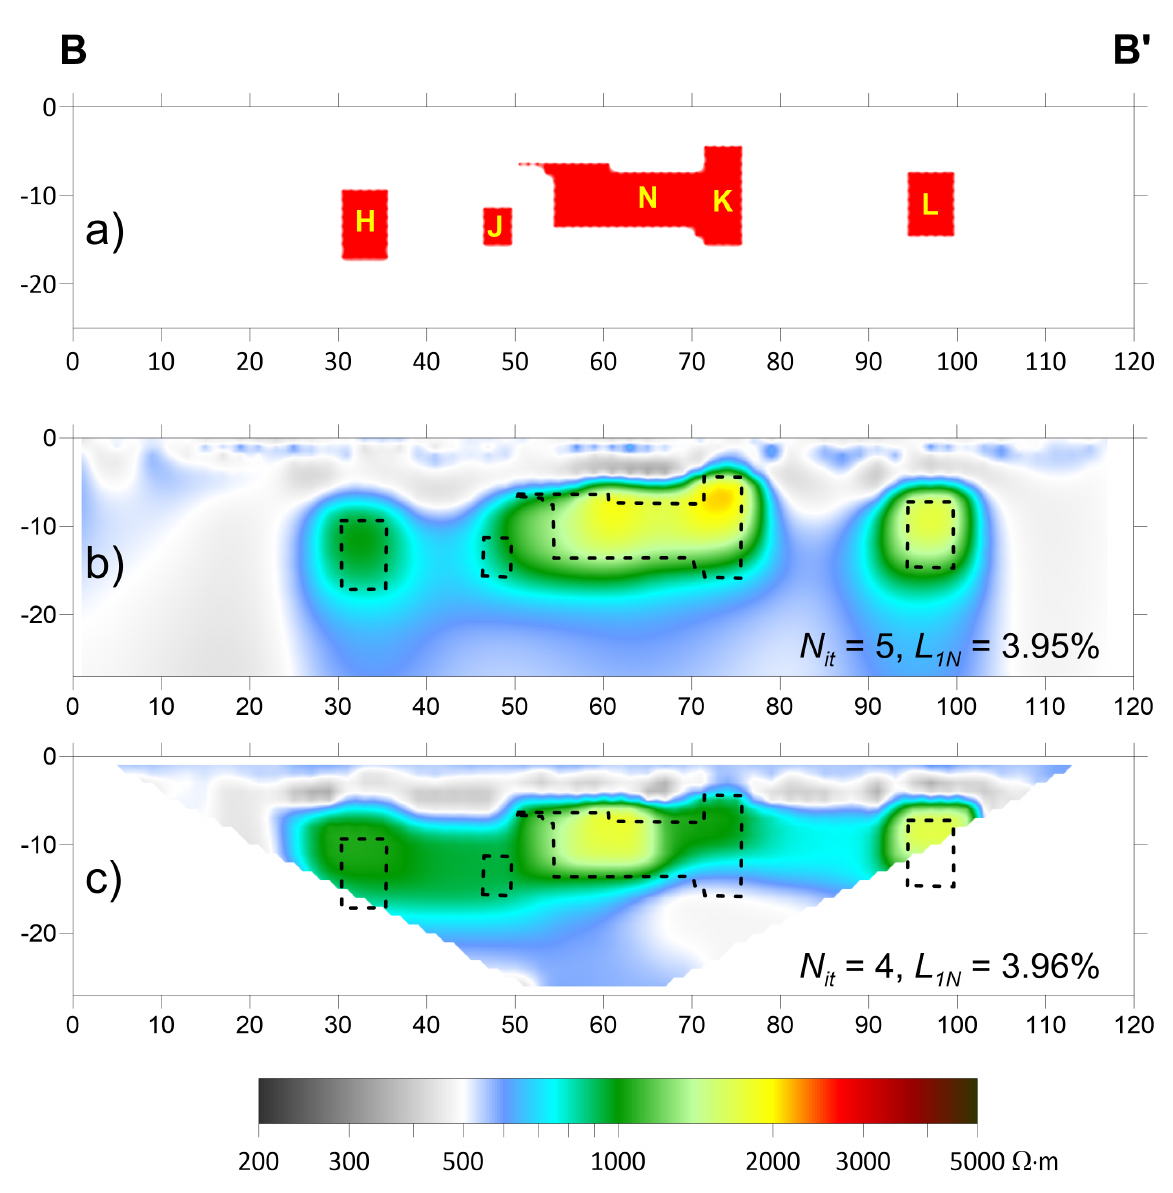
Figure 13. Line B − B’ comparison between simulated inversion of 3D and 2D resistivity surveys. ( a ) Vertical section of the 3D resistivity model. ( b ) Corresponding section of the inverse model obtained by simulating a 3D survey on the geophysical model. ( c ) Inverse model obtained by simulating a 2D survey on the geophysical